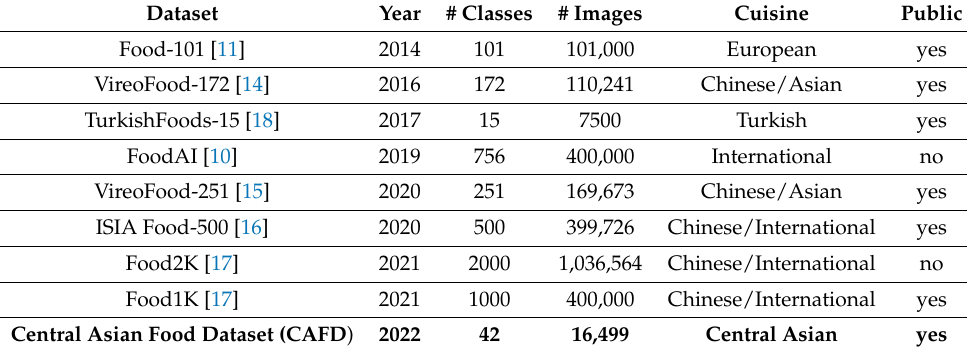
Table 1. Summary of food classification